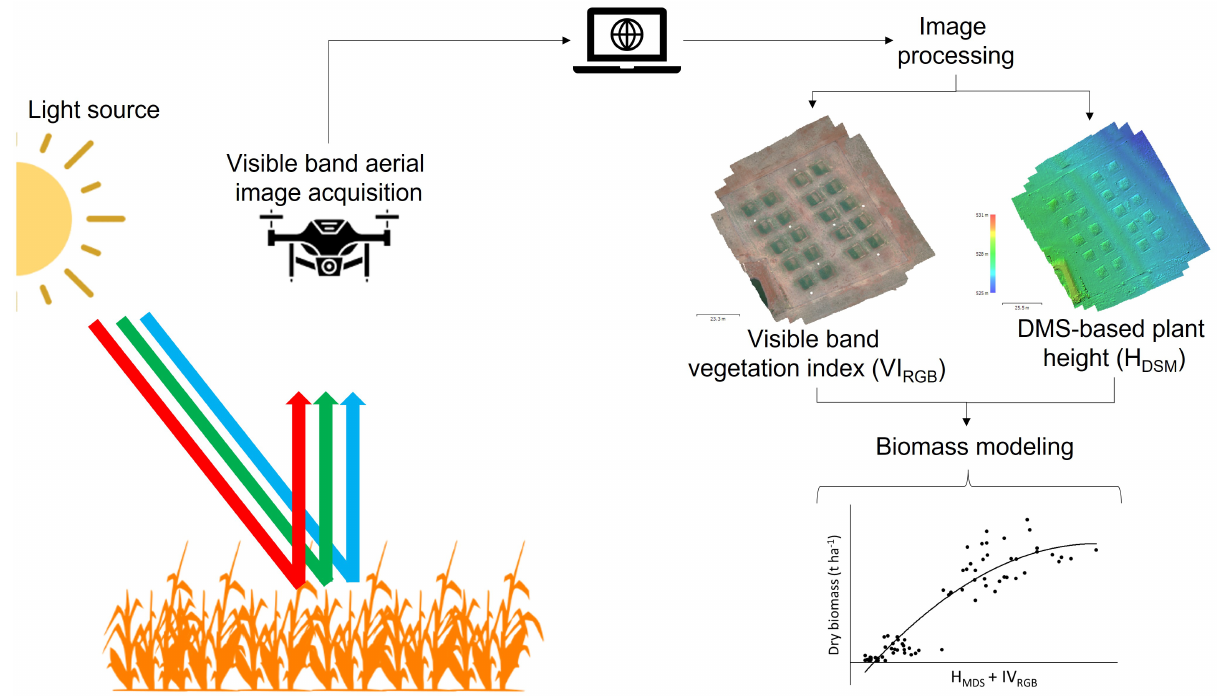
Figure 1. Graphical abstract of the present study to estimate black oat biomass using RGB-based UAV